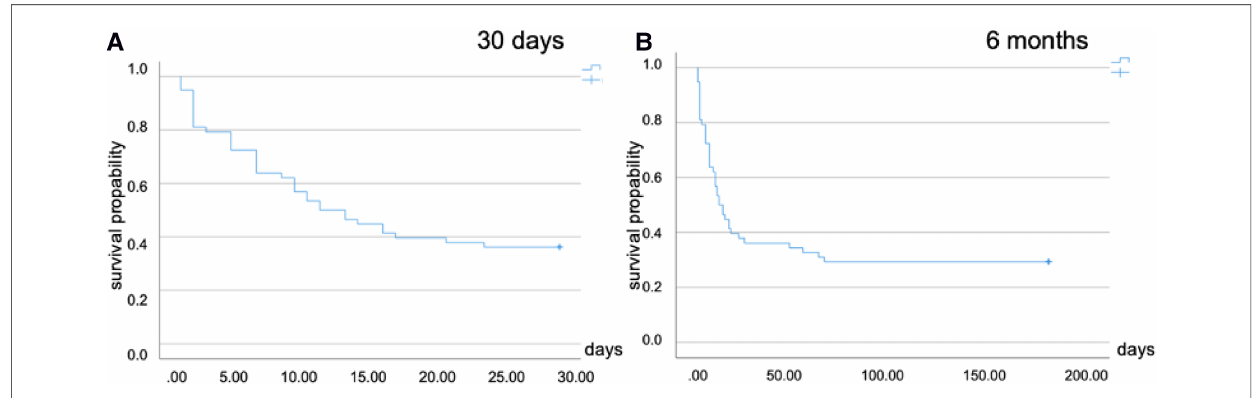
FIGURE 2 Kaplan – Meier plots for cumulative survival following surgical ECLS implantation. ( A ) Thirty-day mortality in the whole cohort (63.8%). ( B ) Six-month mortality (70.7%). ECLS, extracorporeal life